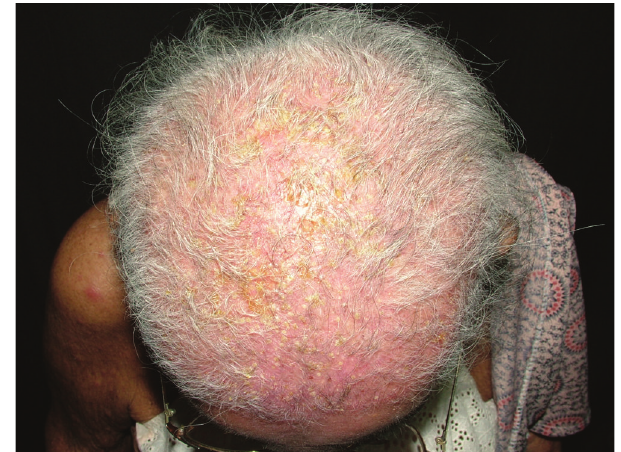
Figure 4: Scalp pustule and scaring alopecia. A 78-year-old woman developed follicular centered pustular eruption on the scalp and scaring alopecia after 3 months of